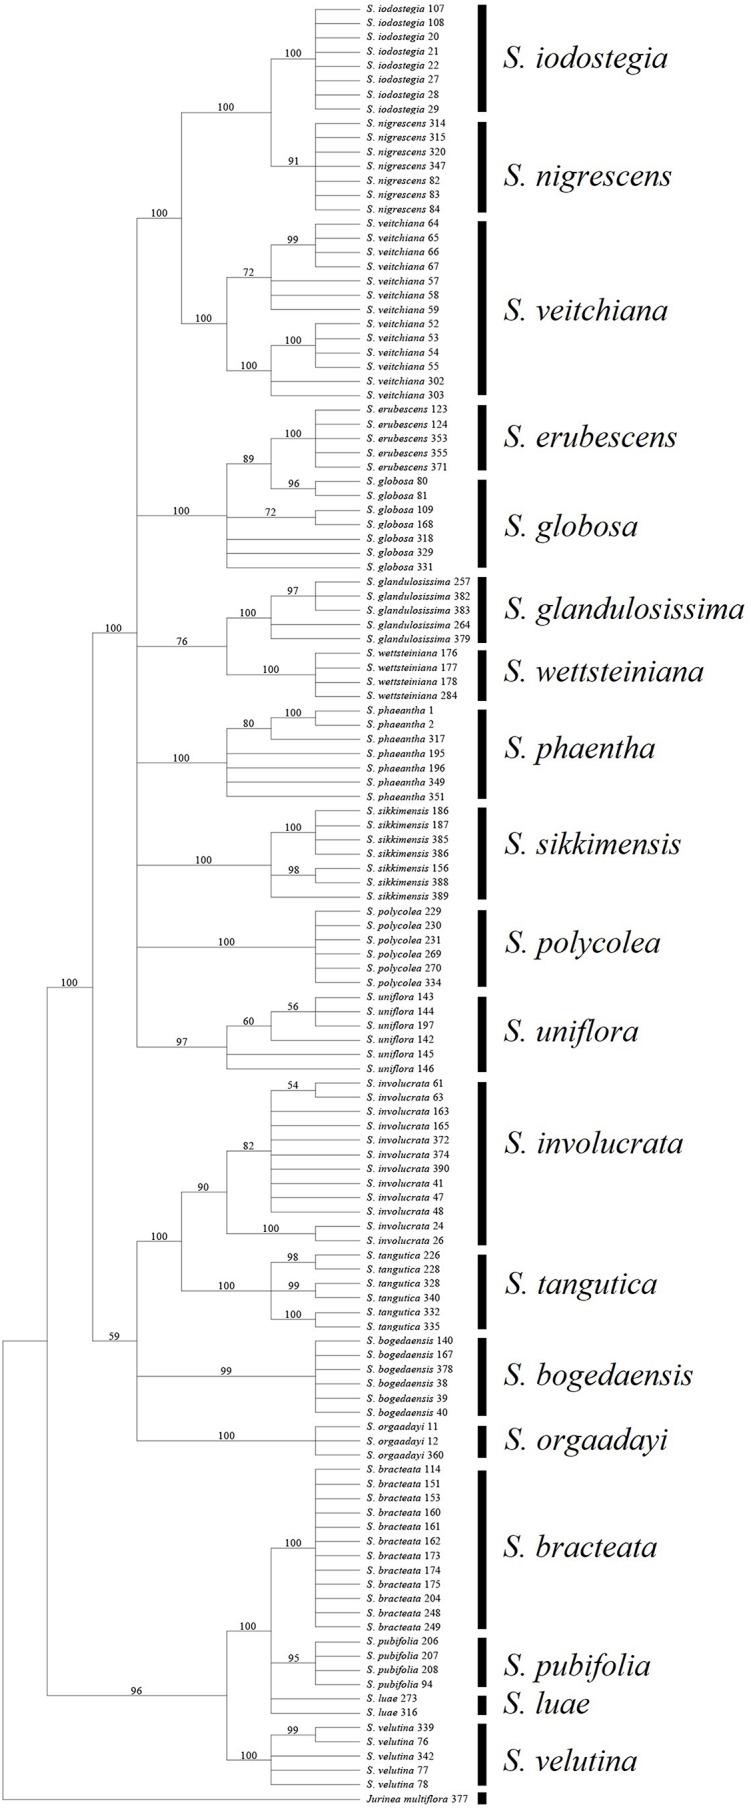
Phylogenetic tree based on Bayesian analysis of ITS + rbcL.